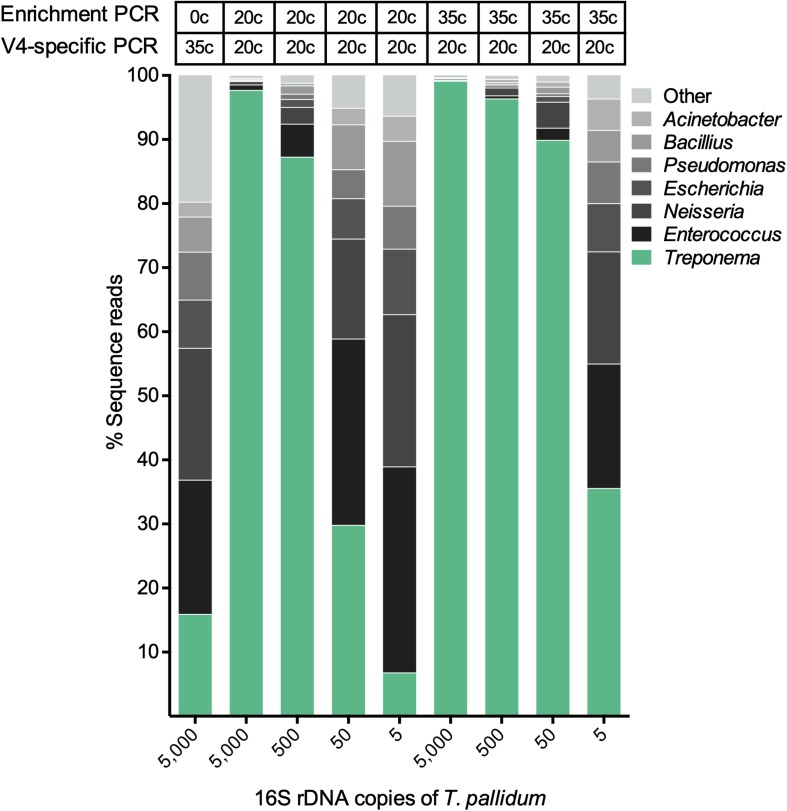
The effect of spirochete enrichment on the detection limit of T. pallidum. Relative abundance of OTUs in percentage of reads for a T. pallidum-spiked microbial mock community (HM-280). The theoretically calculated amount of spike in T. pallidum ranging from 5 to 5,000 16S rDNA copies is shown along the x-axis. The biologically effective range of T. pallidum may differ from theoretically calculated amount (e.g., 5 copies = 4–6 copies). Cycle number for the spirochete enrichment and V4-region-specific PCR is shown above the taxa plots.